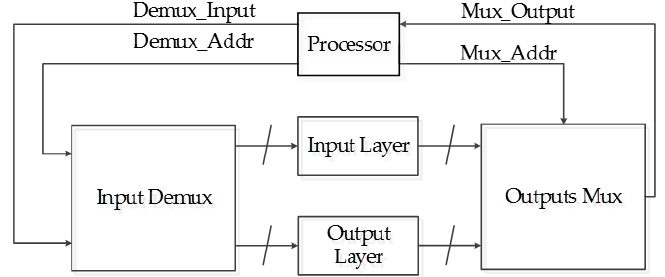
Figure 20. System interconnection.